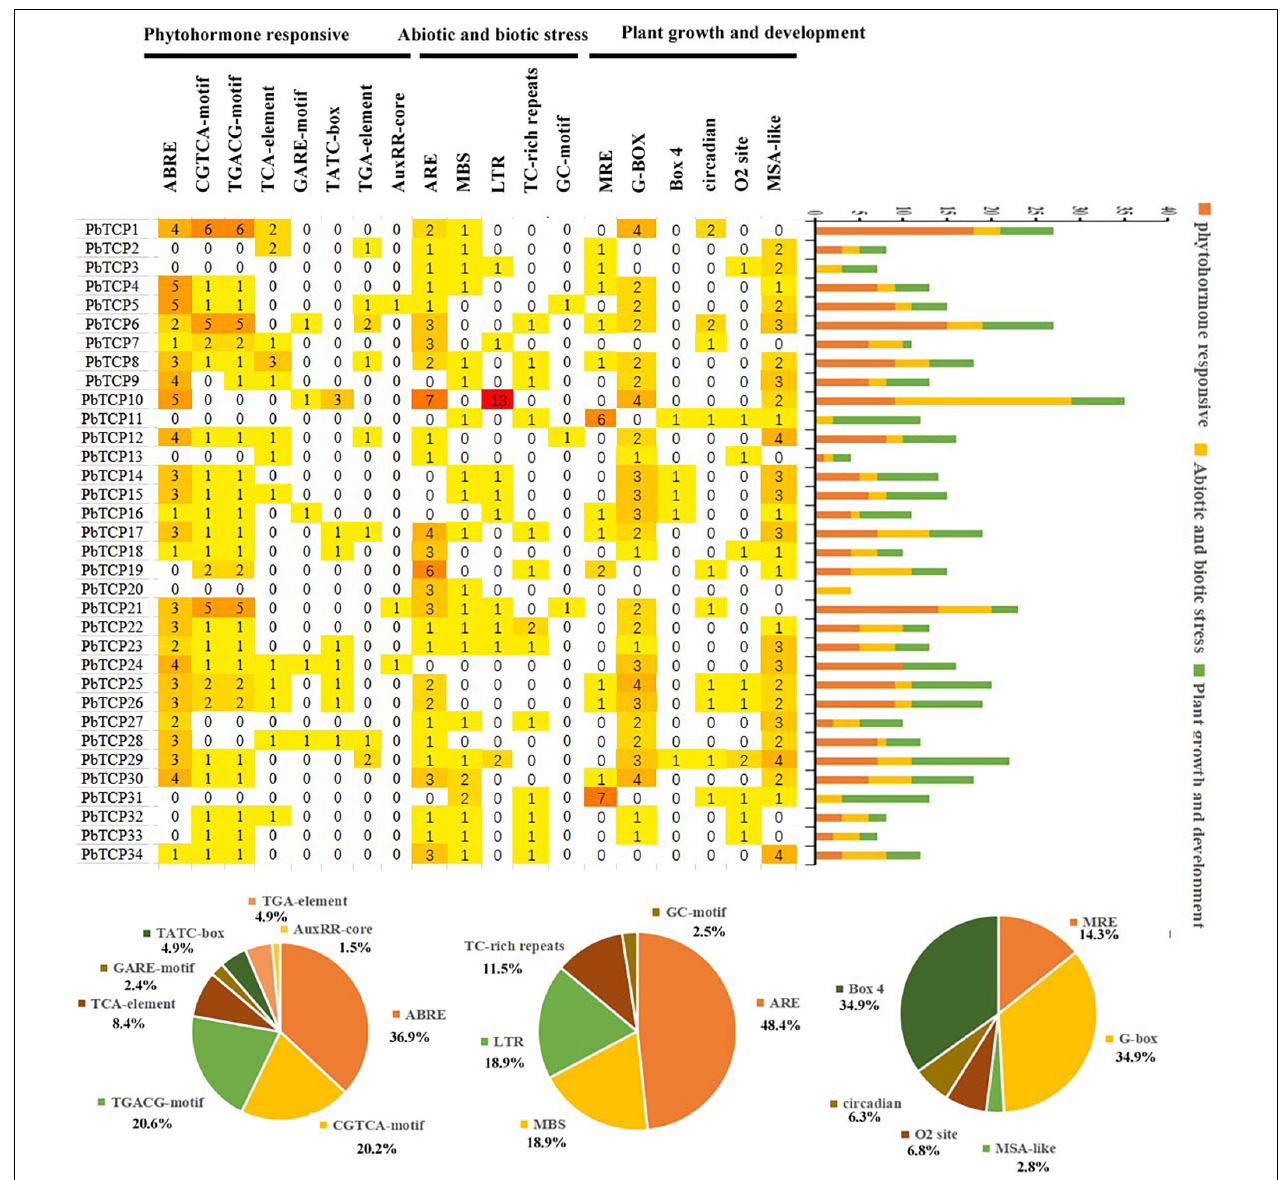
FIGURE 5 | Putative cis -acting regulatory elements in the PbTCP